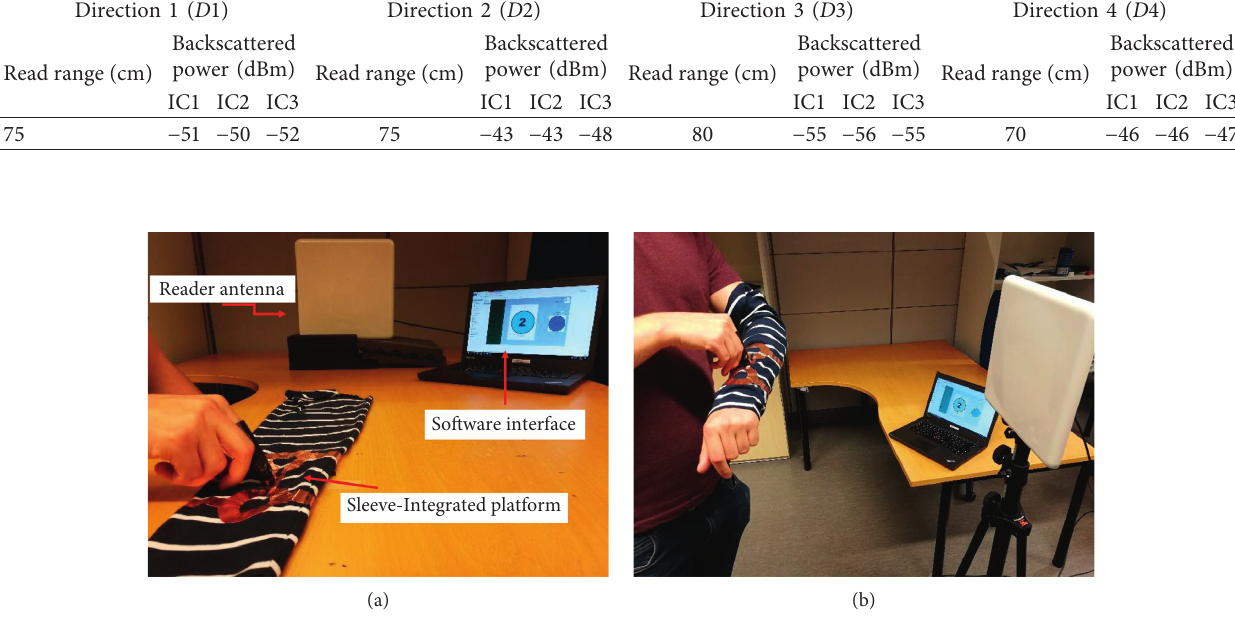
Figure 4: (a) Platform testing setup on a table and (b) on body.